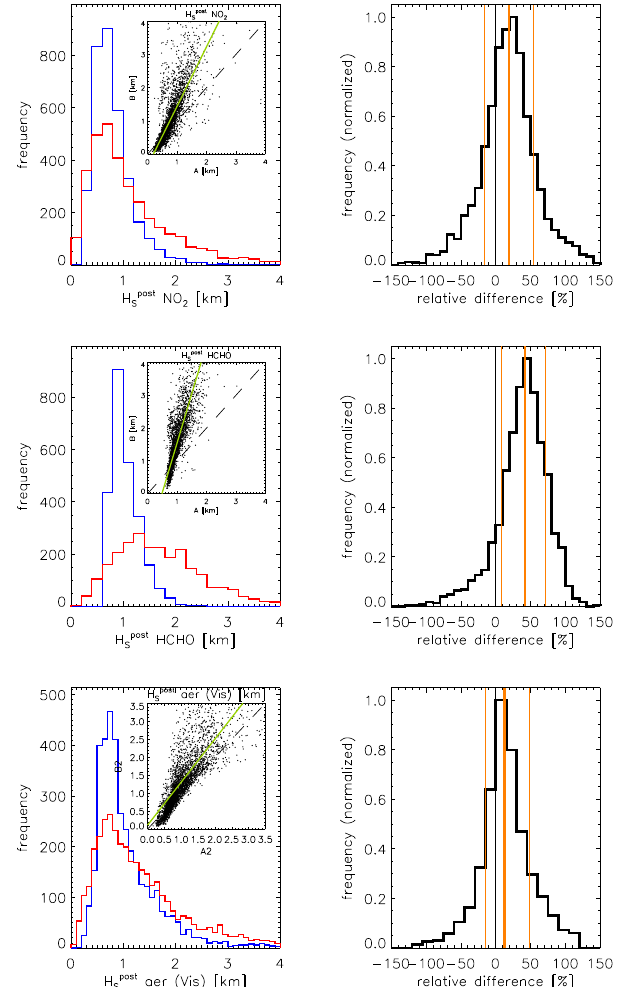
Figure 15. Similar to Fig. 14, but here for the a posteriori scale height ( H post s , Eqs. 6 and 7). The three rows refer NO 2 , HCHO and aerosols respectively. Left column: frequency distributions obtained with method A (blue) and B (red). Second column: frequency distri- bution of relative differences (B minus A). Lines in orange indicate the quartiles.